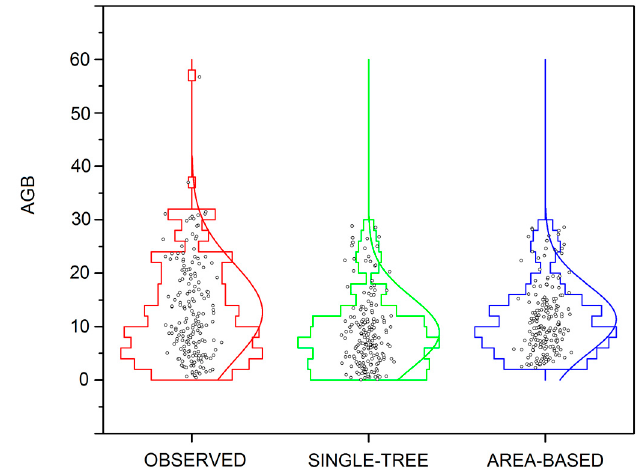
Figure 7. Distribution of the biomass observed and predicted by the two models for the field plots. Values in in t·ha − 1 .